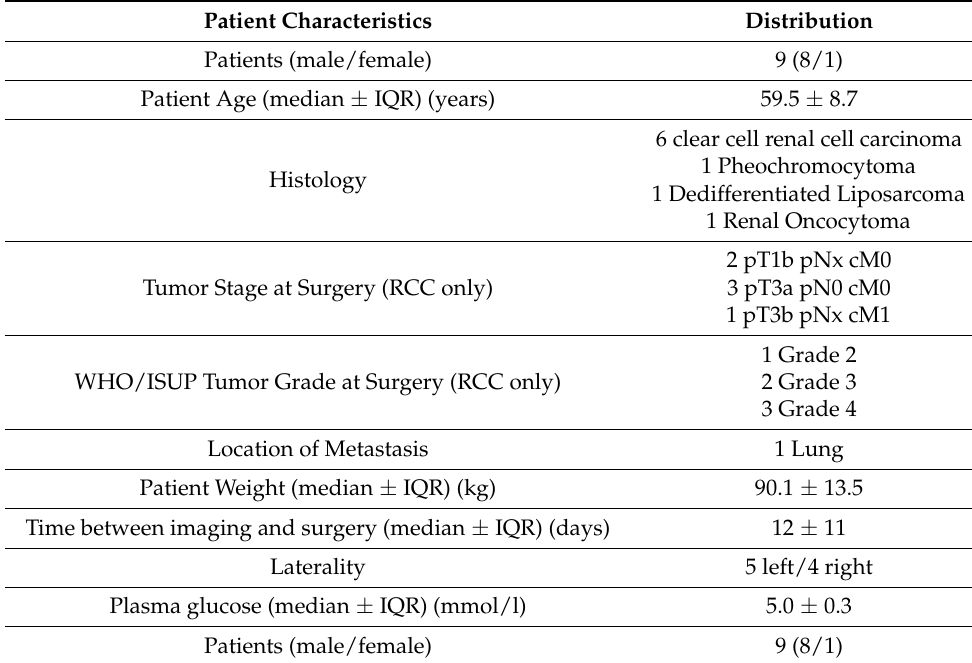
Table 1. Patient